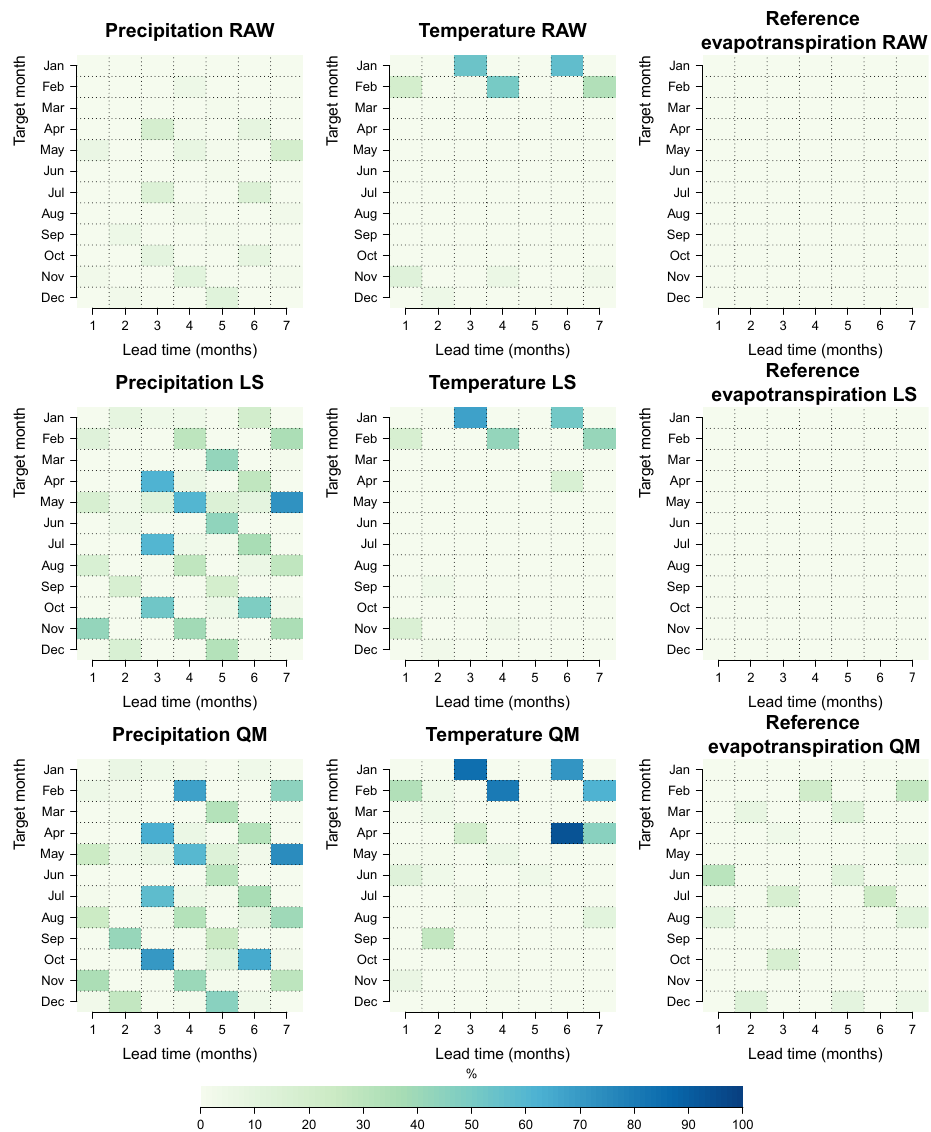
Figure 11. Percentage of grid points for which we fail to reject the null hypothesis of uniformity using the Anderson–Darling test at the 5% significance